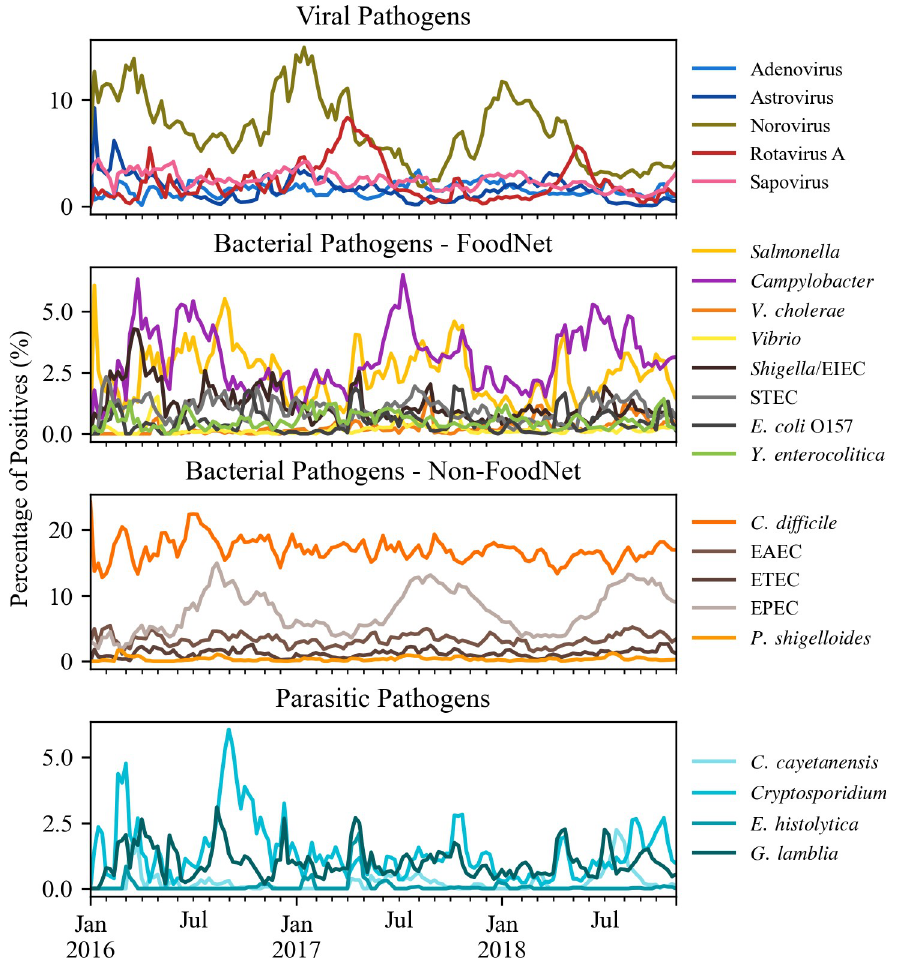
Fig 3. Weekly percentage of positives for viral (N = 12,588), bacterial FoodNet (N = 7,798), bacterial non-FoodNet (N = 27,623), and parasitic (N = 2,183) GI pathogens detected using BioFire Trend from January 2016 through October